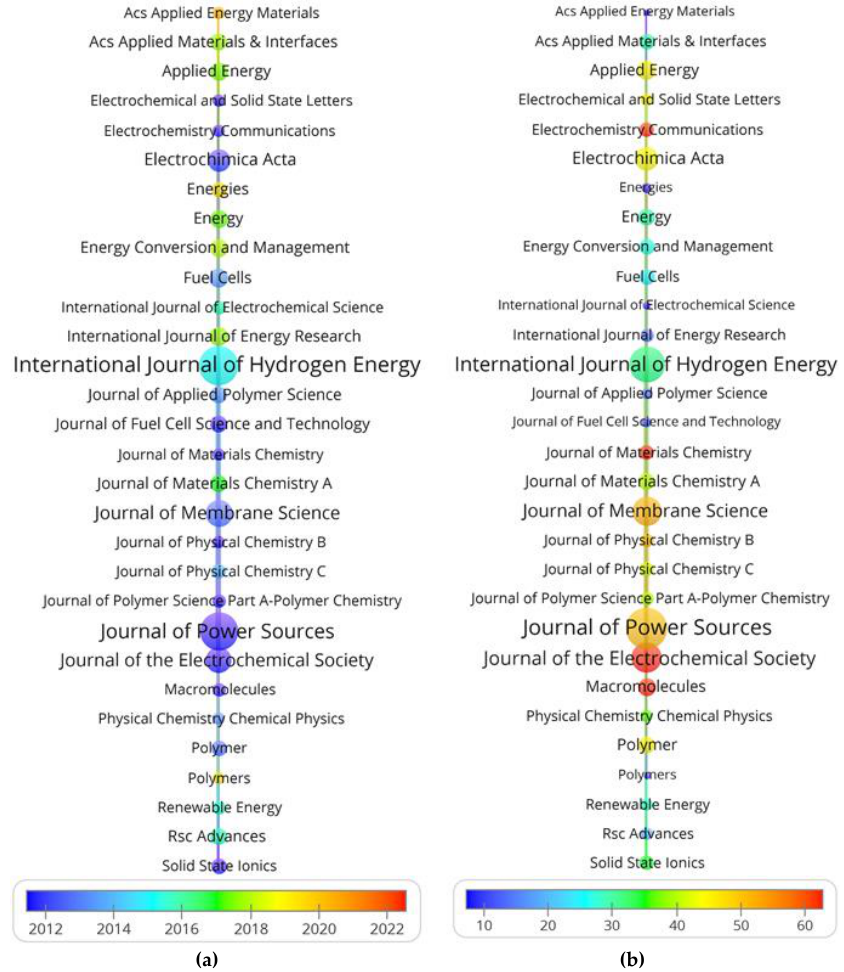
Figure 2. Source journal analysis of main journals ( a ) average publication year ( b ) average citations.